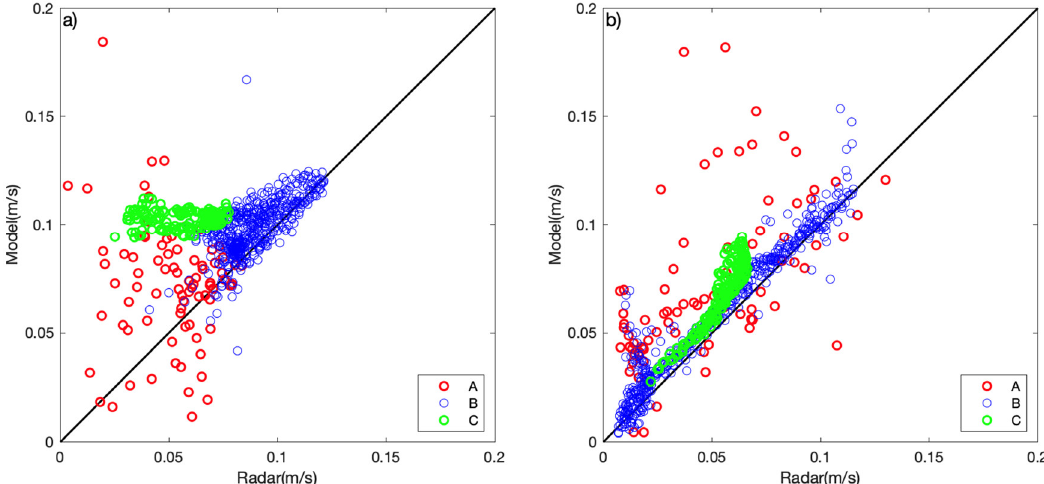
Figure 9. Comparison between model and radar radial components of the tidal ellipse at ( a ) Shangchuan and ( b ) Wanshan stations. Points in area A, red circles; points in area B, blue circles; points in area C, green circles.